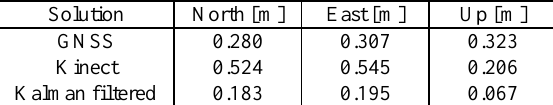
Table 5. Standard deviations between the computed solutions and the reference trajectory measured with the